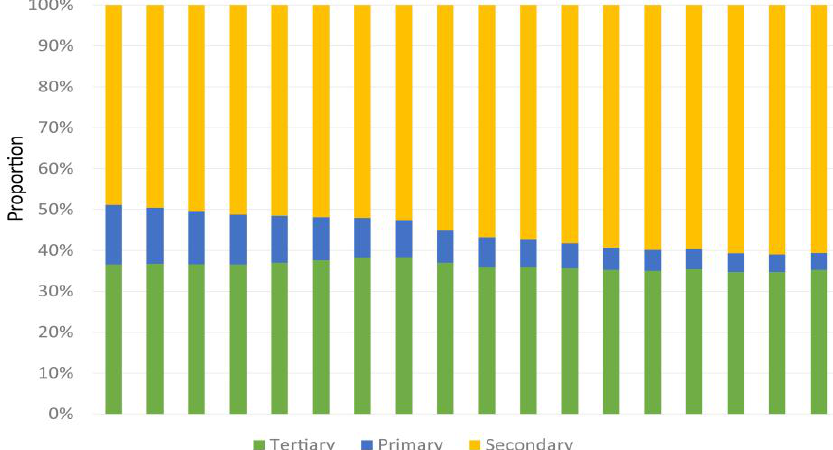
Figure 6. Industrial Structure in Guangdong Province.